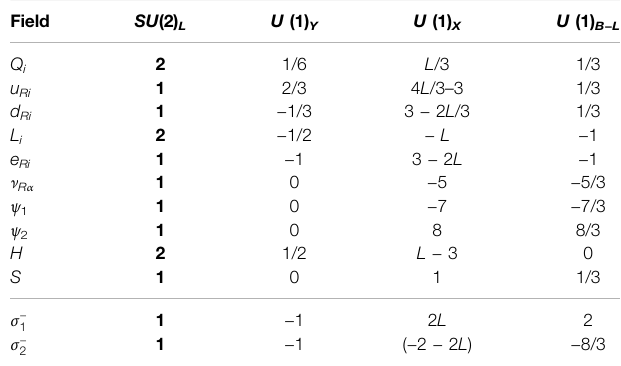
TABLE2| X andproper B − L normalizedchargesforthe fi rstsolutionin Table1 (3, 3,3, − 5, − 5, − 7,8),forwhich m =3, ] = − 5, δ =2andthereforefrom Eq.6 , s = 1. For the column U (1) B − L we fi x L = 3 and change X → X /3. Moreover, i = 1, 2, 3 and α = 1, 2. The electroweak quantum numbers are also shown for each one of SM fi elds, the extra SM-singlet chiral fermions, and the scalars in the last four rows. Field